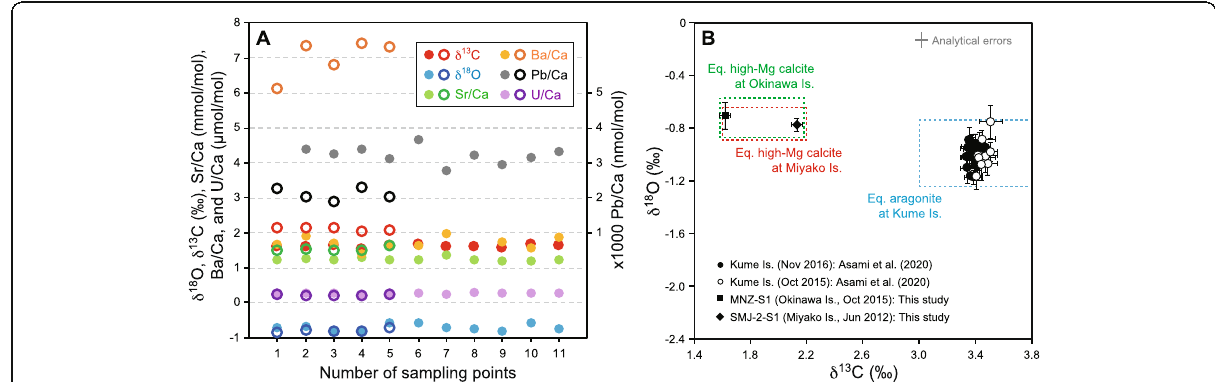
Fig. 4 A Within-skeleton variations in the geochemistry of the SMJ-2-S1 (open circles) and MNZ-S1 (dotted circles) samples. The Ba/Ca and Pb/Ca data at the respective sampling point of X = 8 and X = 1 for the MNZ-S1 sample were evaluated as outliers based on the Smirnov-Grubbs test ( p < 0.025). B Scatter plot of δ 13 C and δ 18 O averages with 1 σ standard deviations of coeval skeletal portions in individual samples. Red and green areas are shown respectively as estimated ranges of isotopically equilibrium calcite precipitated at the study sites of Miyako and Okinawa Islands. For comparison, aragonite sclerosponge ( Astrosclera willeyana ) data and an equilibrium aragonite estimate are also shown (Asami et al.